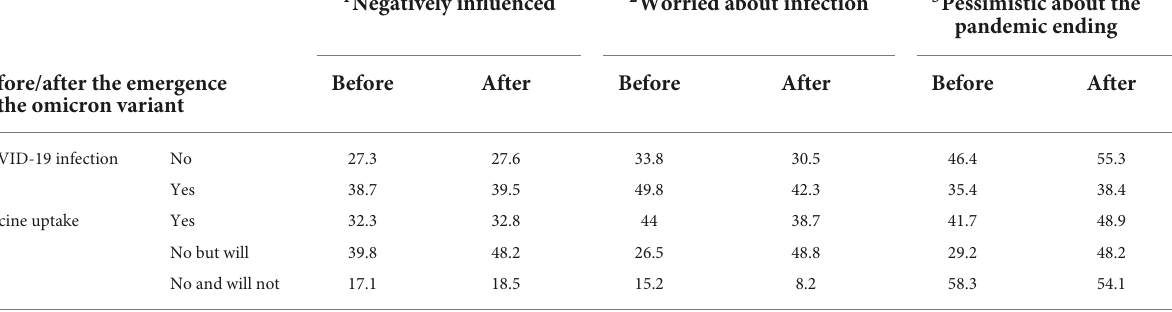
TABLE 3 The weighted percentages of participants who perceived their lives were negatively influenced by the COVID-19 pandemic, those who worried about COVID-19 infection frequently, and those who believed that there would be at least another year before the end of the pandemic, stratified by the status of COVID-19 infection and vaccine